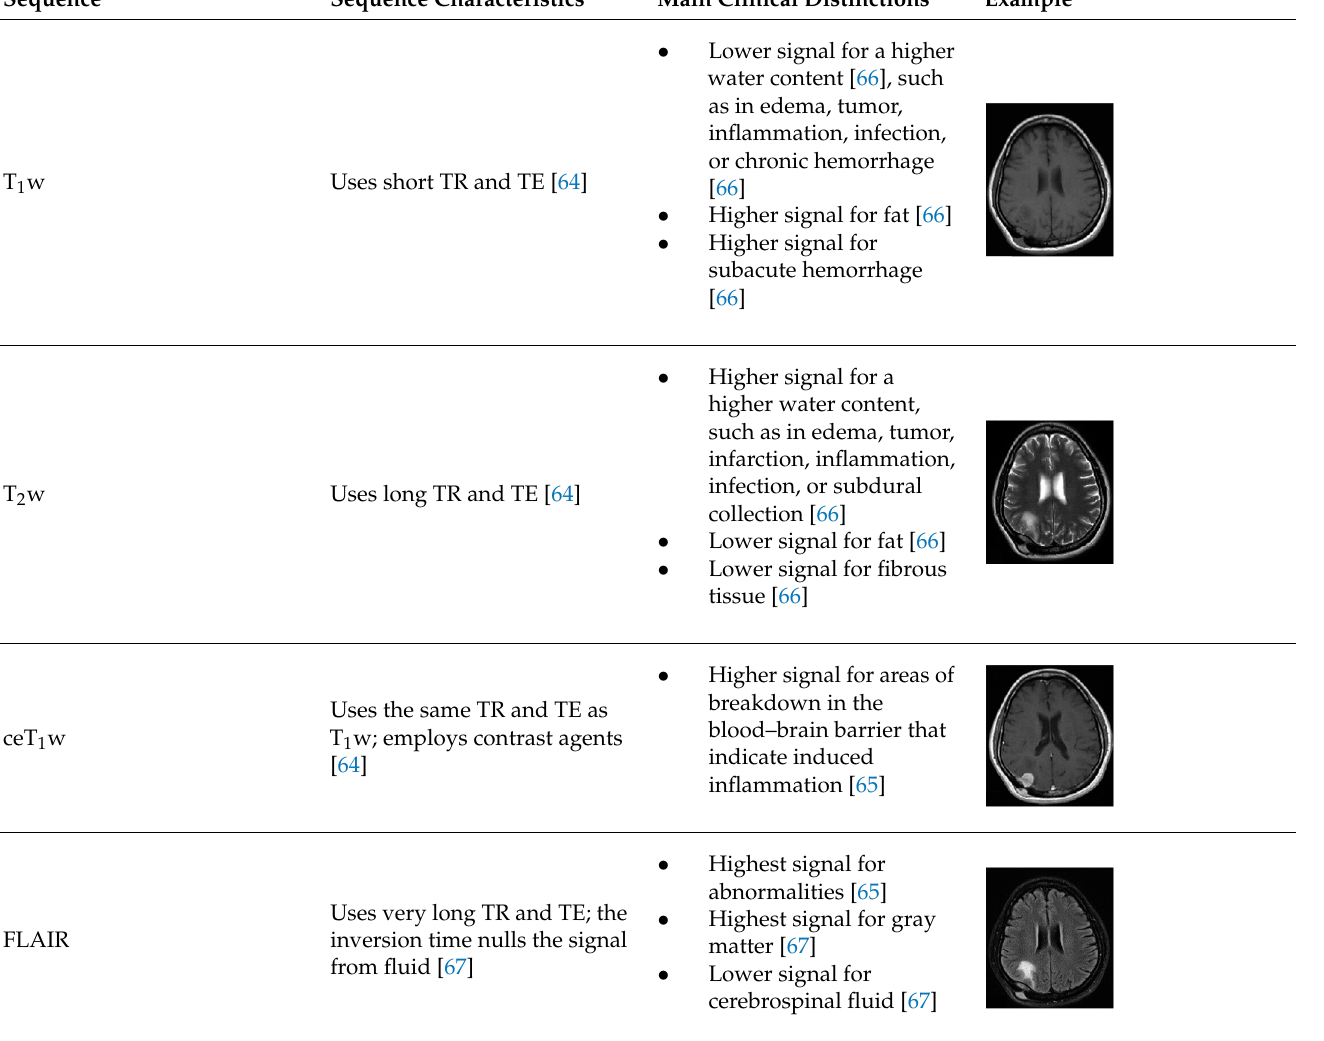
Table 3. The imaging configurations and main clinical distinctions of T 1 w, T 2 w, ceT 1 w, and FLAIR. [64]. Table 3 lists the imaging configurations and the main clinical distinctions of T 1 w, T 2 w, ceT 1 w, and FLAIR with information retrieved from [64–67]. Sequence